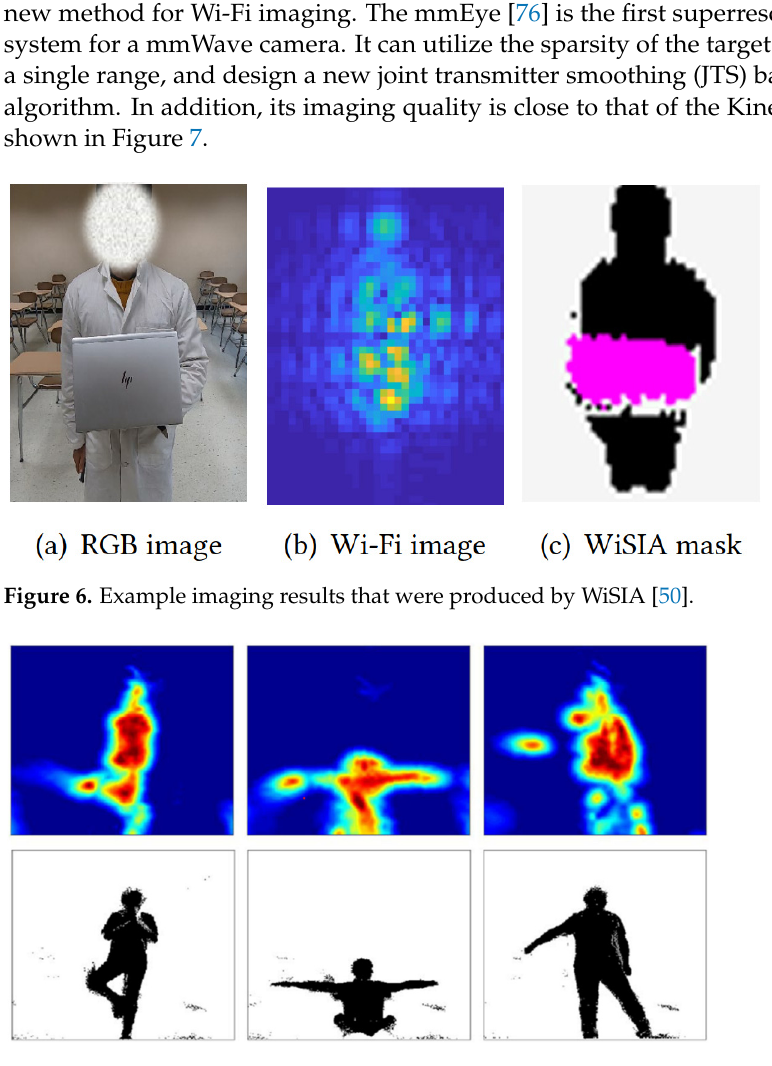
Figure 7. Example imaging results that were produced by 60 GHz Wi-Fi signals [76]. The upper and lower layers are images from the mmEye and Kinect cameras, respectively.